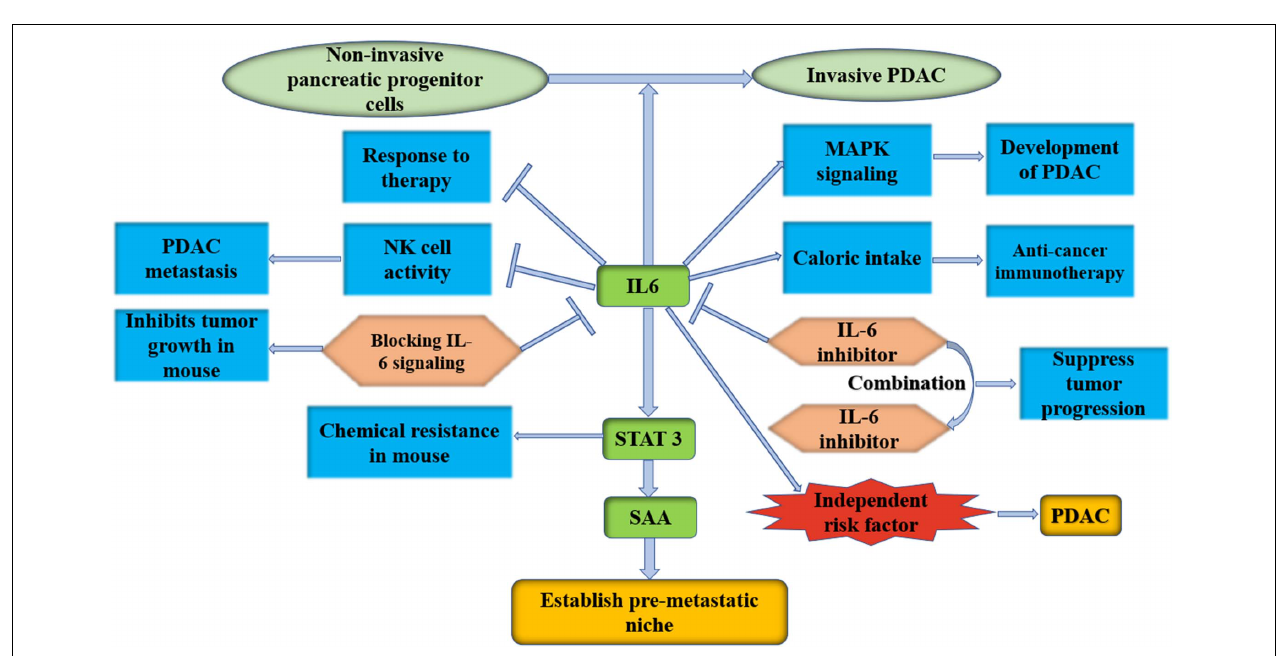
FIGURE 3 | Target IL1/LIF/JAK/ STAT 3 pathway, which could activate iCAFs in pancreas. It may become potentially effective targeted therapies for PDAC. IL-1 β , interleukin-1 β ; IL-1R, interleukin-1 receptor; LIF, leukemia inhibitory factor; JAK, Janus kinase; STAT 3, signal transducer and activator of transcription 3; iCAFs, inflammatory cancer-associated